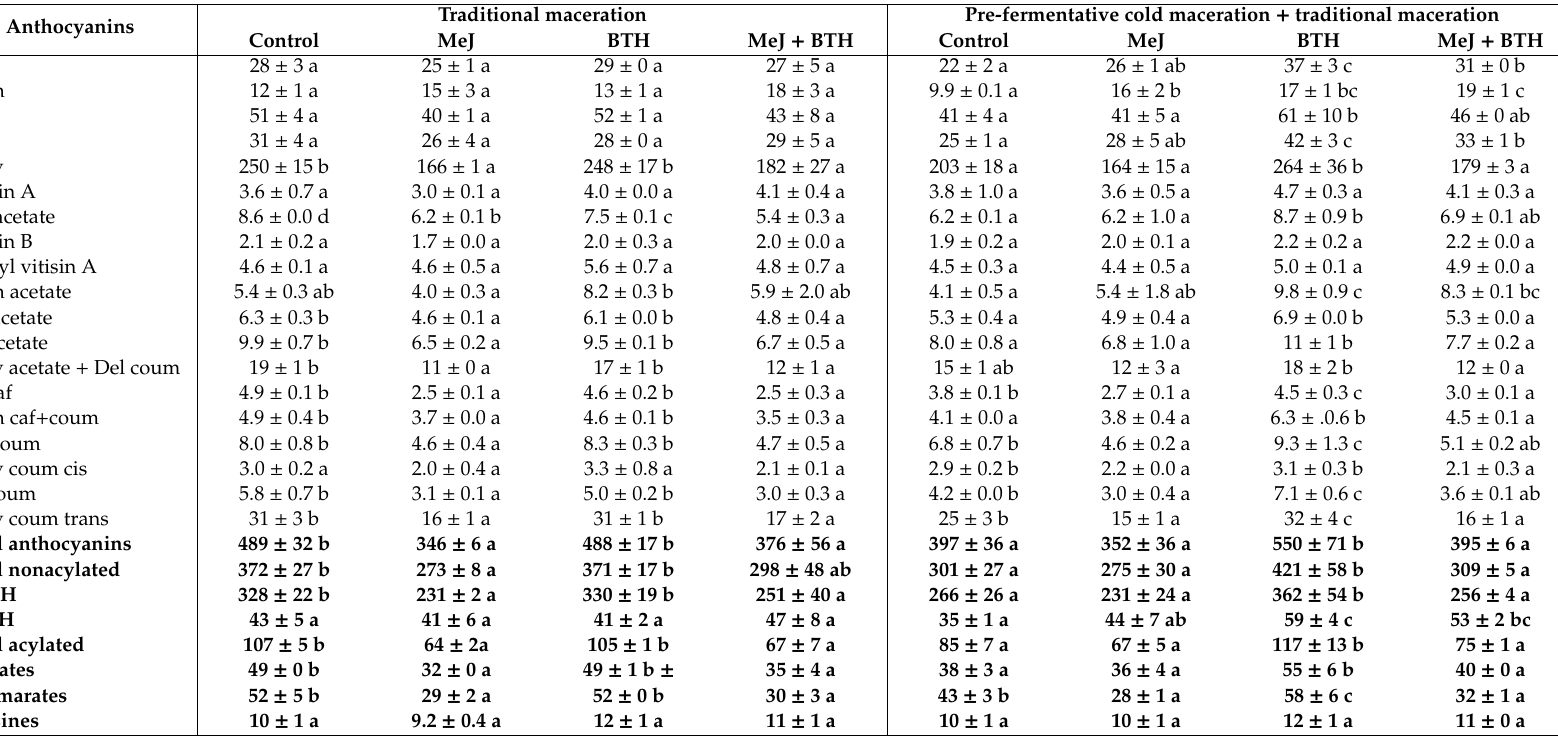
Table 5. Concentration of anthocyanins expressed as mg / L at the end of alcoholic fermentation in Monastrell wines. ( 2017 ). Traditional Anthocyanins